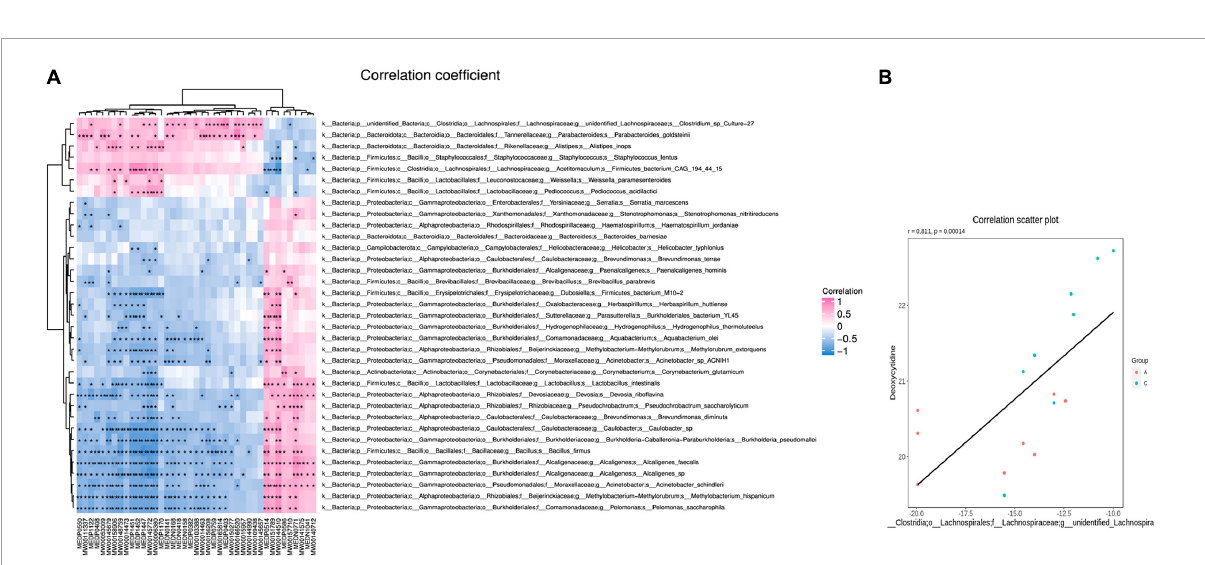
FIGURE7 Correlation of gut microbiota and fecal metabolites. Heatmap summarizes the correlation between fecal metabolite alterations and gut microbiota perturbations at the species level in APP/PS1 and wild-type mice (A) (pink: positive correlation, blue: negative correlation). Scatter plot illustrates the statistical association between the relative abundance of Clostridium sp. Culture-27 and concentration of deoxycytidine (B) . Groups: A, APP/PS1 double-transgenic mice; C, wild-type control group of C57BL/6J mice; n = 8/group. * P < 0.05, ** P <